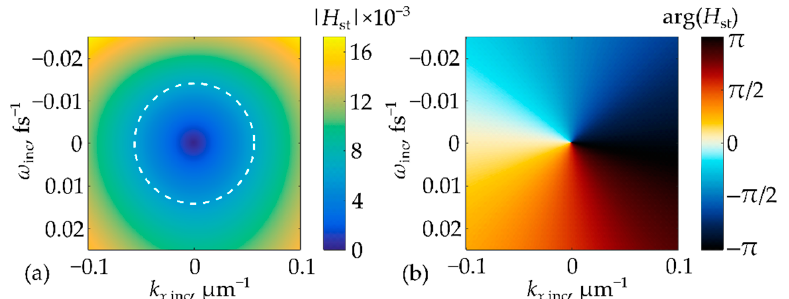
Figure 3. ( a ) Amplitude (absolute value) and ( b ) phase (argument) of the TF of the designed structure. White dashed circle shows the 1/ e 2 level of the incident pulse spectrum. Figure 4a,b show the amplitude and phase of the spatiotemporal envelope of the pulse reflected from the structure. The reflected pulse envelope was calculated